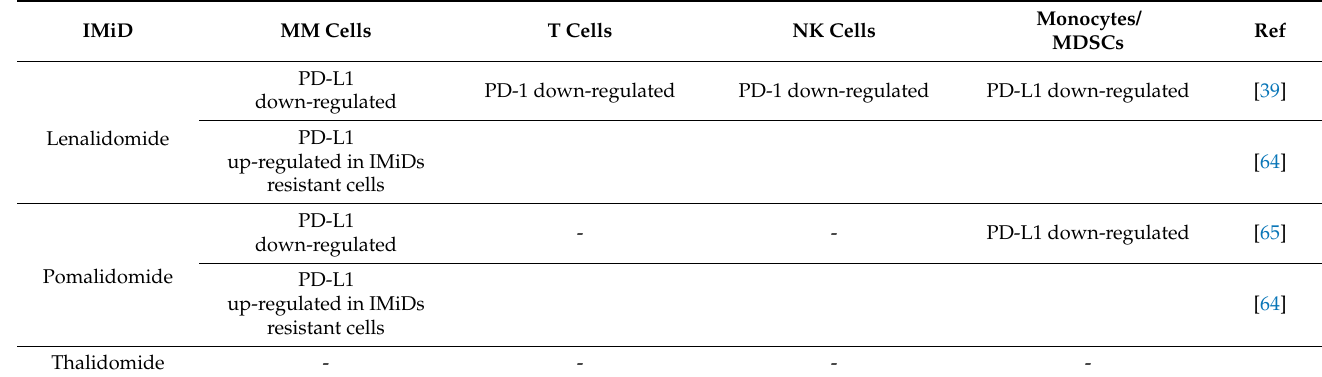
Table 2. PD-L1/PD-1 regulation in MM niche by immunomodulatory drugs (IMiDs).